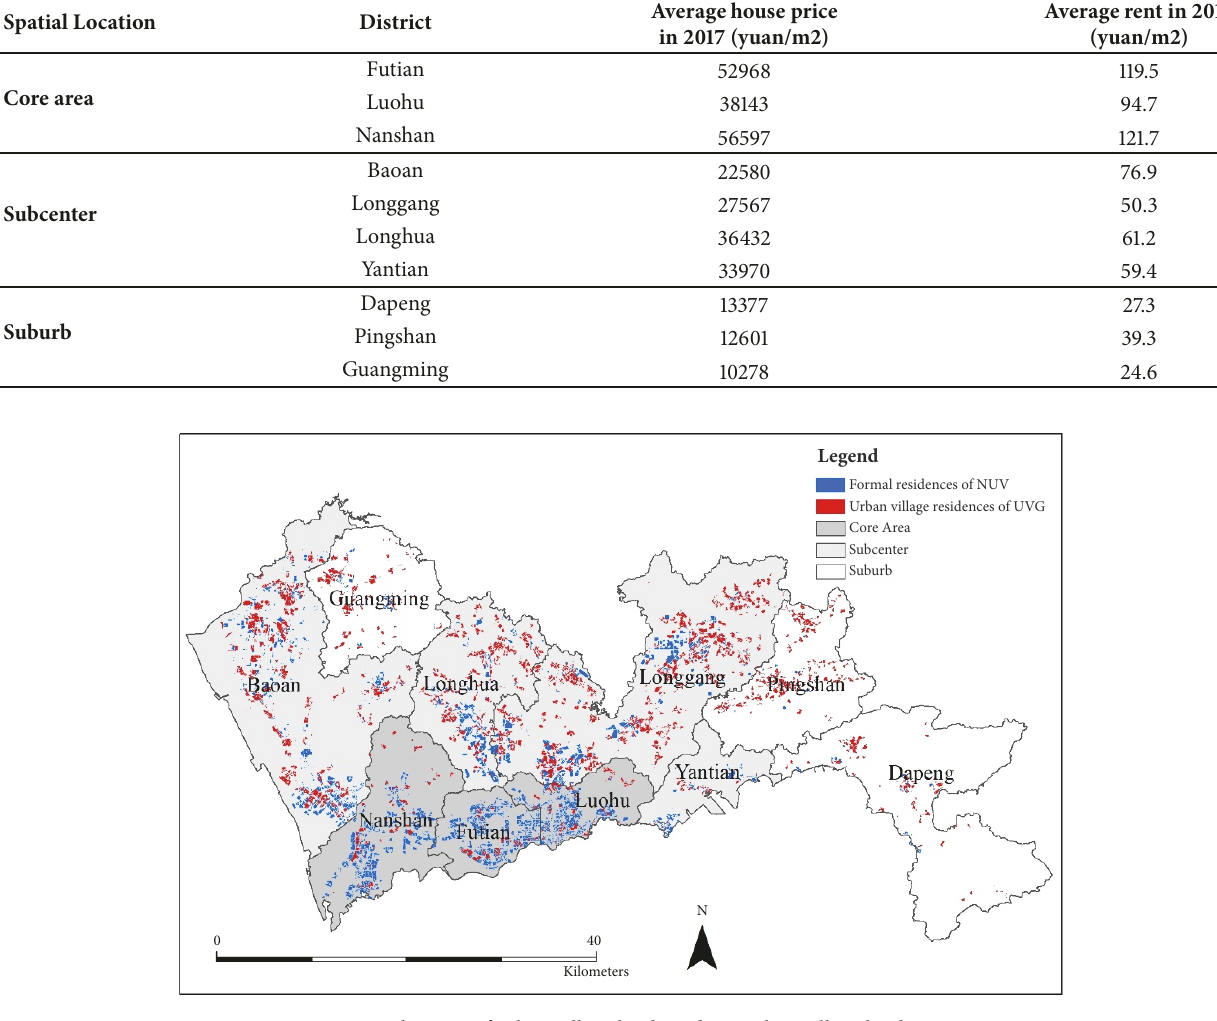
Figure 1: Distributions of urban village lands and nonurban village lands in